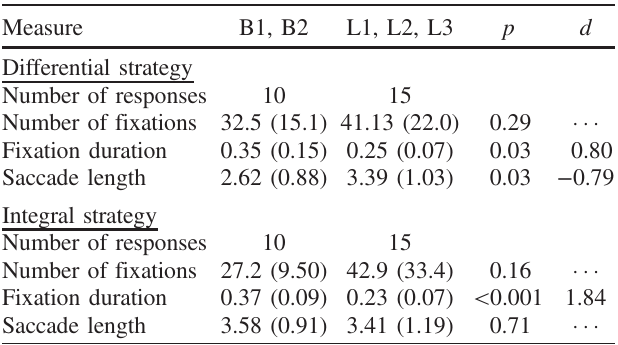
TABLE VI. Comparison of classical eye-tracking measures between best (B1, B2) and worst performers (L1, L2, L3) for each strategy.